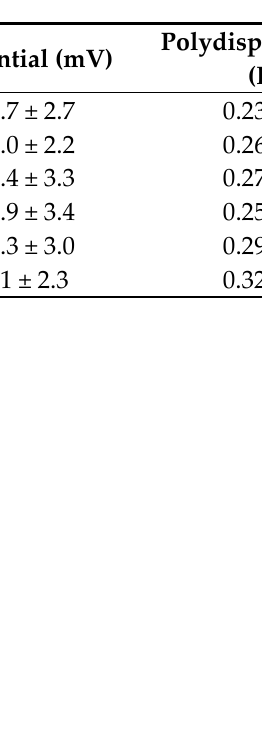
Table 1. Physicochemical properties of magnetic anionic liposome/atelocollagen (ATCOL) com- plexes.